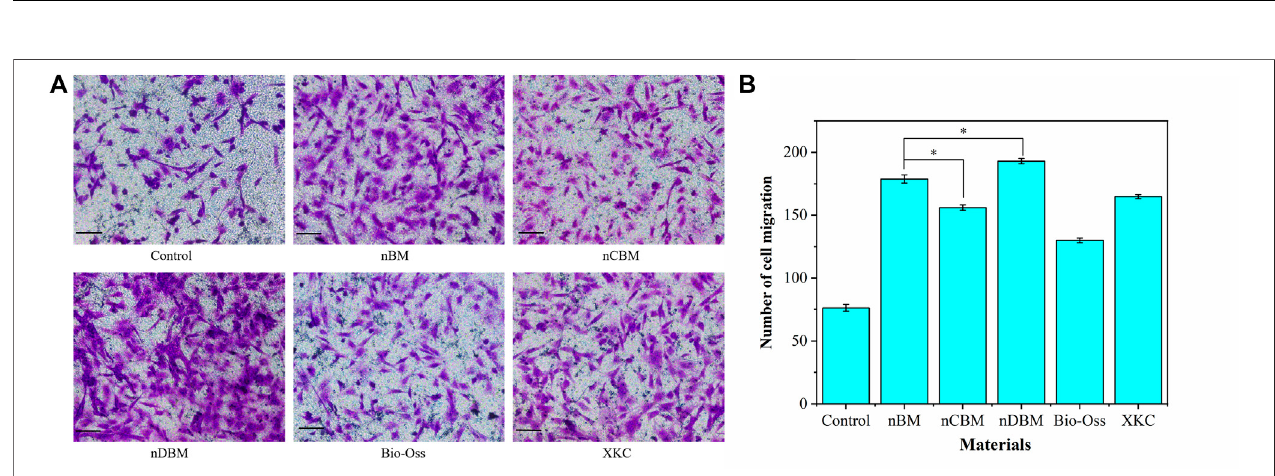
FIGURE 10 | (A) Effects of different bone powders on the migration of BMSCs, stained with crystal violet. Scale bars: 100 μ m. (B) Quantitative analysis of BMSC migration. * p < 0.05.